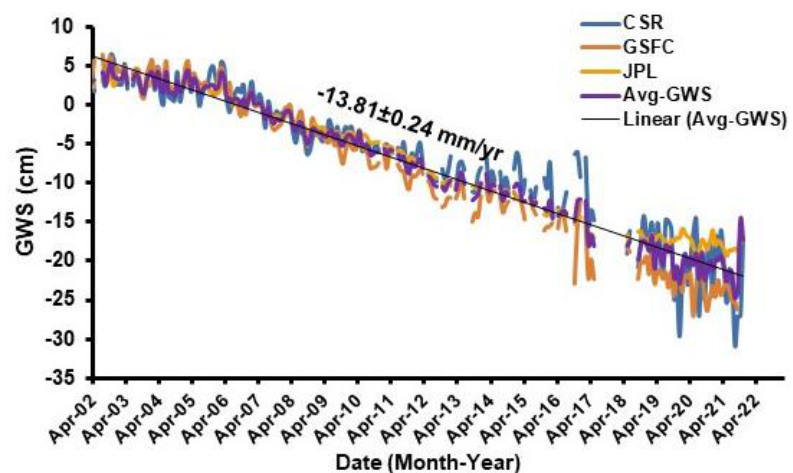
Figure 7. Monthly series and secular ΔGWS trends for the entire study area.